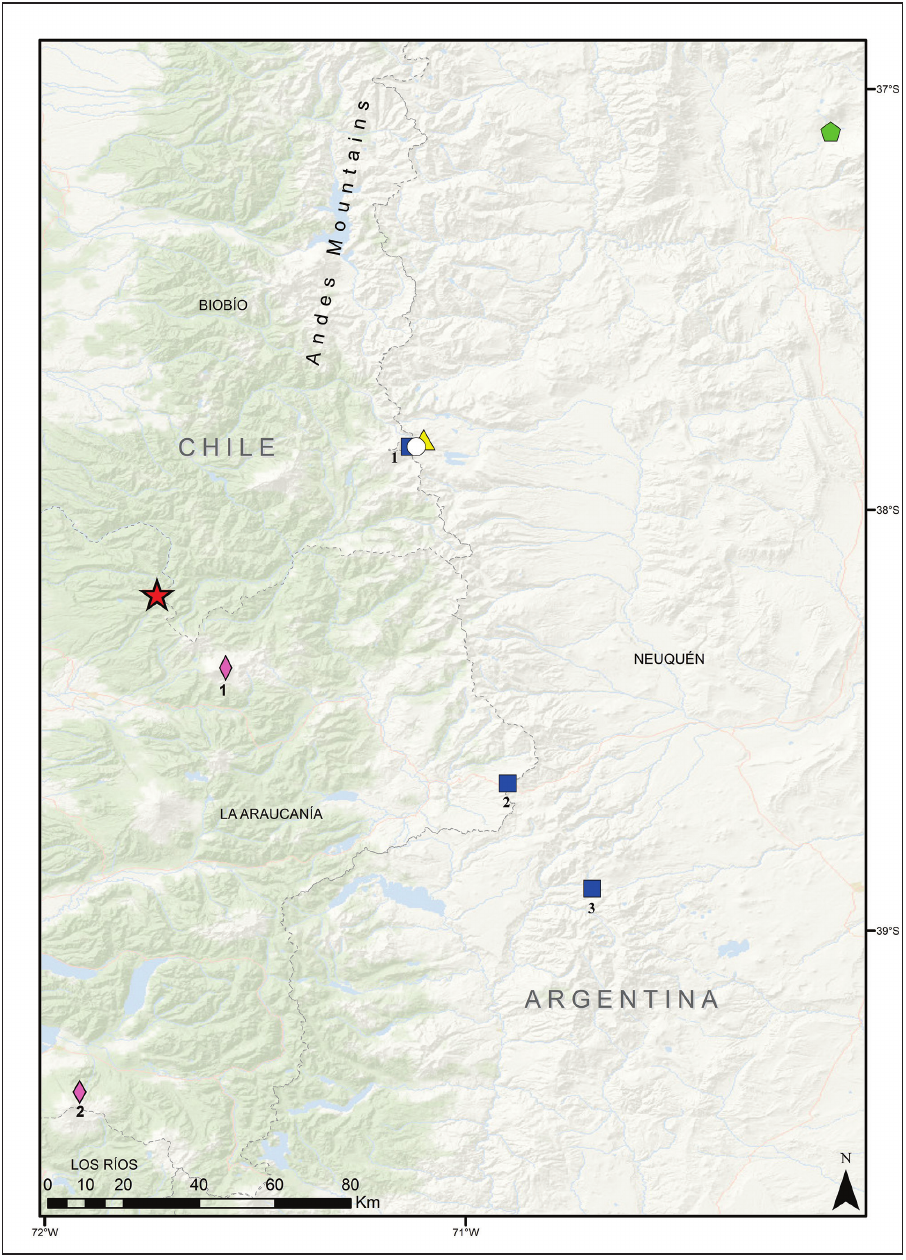
Figure 7. Distribution map for Liolaemus leftrarui sp. n. with closely related L. villaricensis and geo- graphically proximate species that feature a lack of precloacal pores. Red star: L. leftrarui sp. n. (Laguna Verde and Lagunillas). Pink diamond: L. villaricensis (1= Lonquimay Volcano, 2 = Villarrica Volcano). Blue squares: L. coeruleus (1= Copahue, 2= Pino Hachado, 3= Primeros Pinos). White circle: L. tregenzai (Copahue). Yellow triangle: L. neuquensis (Copahue). Green pentagon: L. punmahuida (Tromen